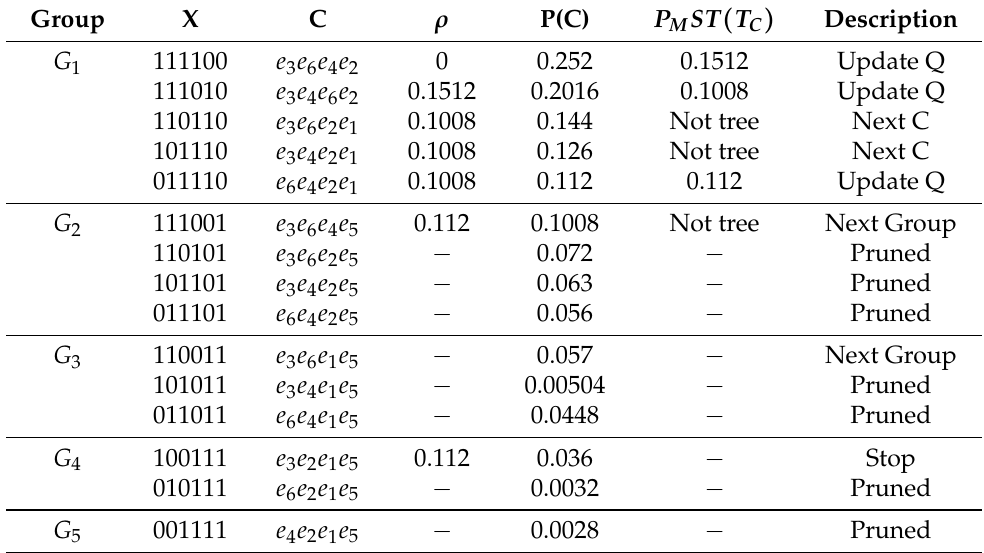
Table 1. A running example of EF_OTF